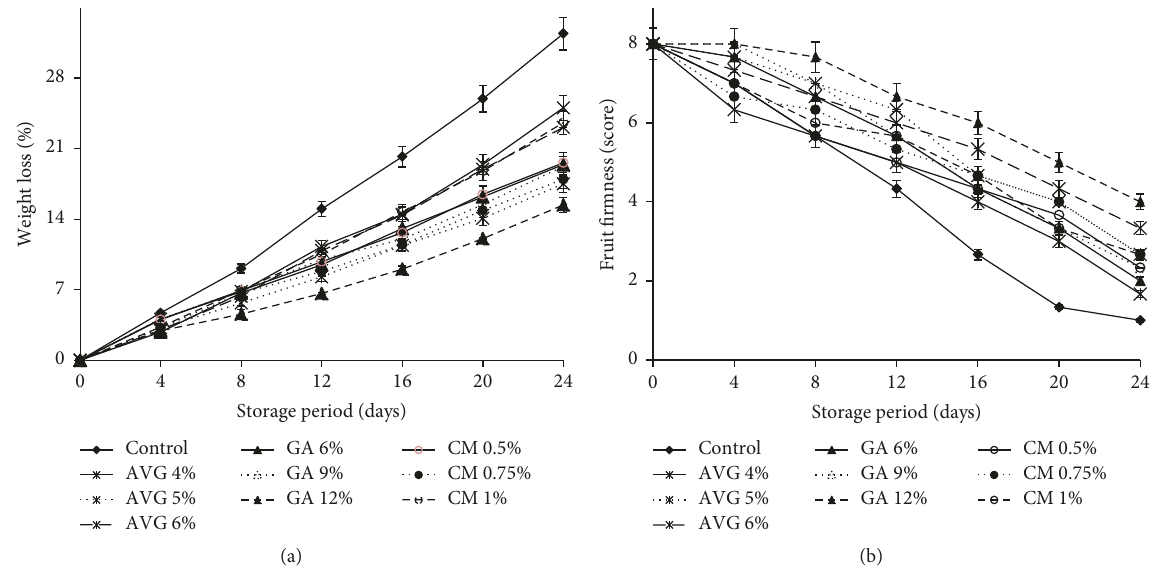
Figure 1: Effect of different coating treatments on the weight loss and fruit firmness of bell pepper during cold storage at 8 ± 1 ∘ C for 24